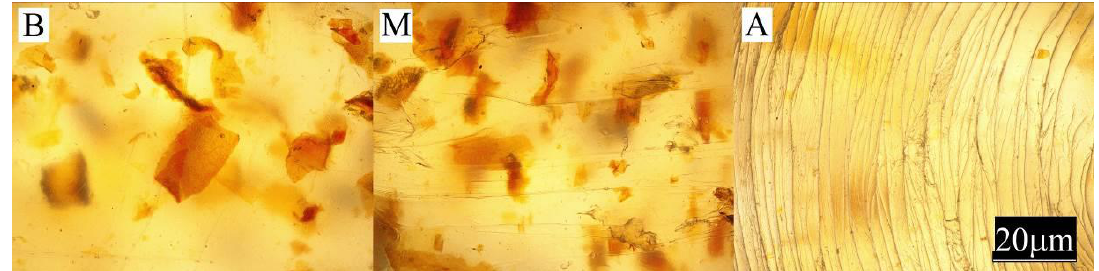
Figure 8. The appearance of individual parts of the injection moulding obtained with a 5% content of bran fraction with a grain size of 0.4–0.6 mm at measuring points A, M, B (the position of the points is marked in Figure 1).